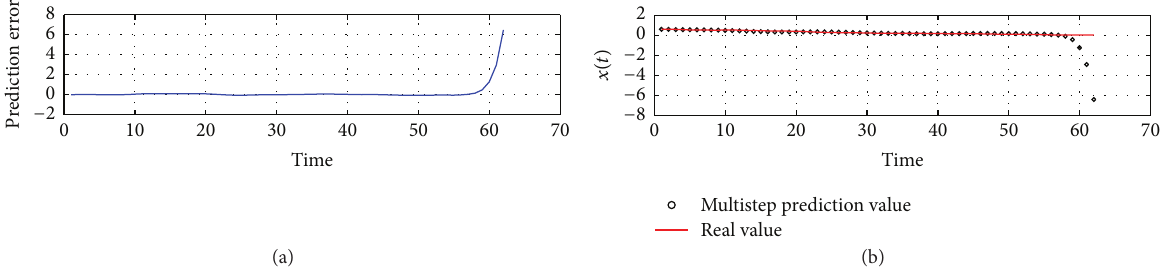
Figure 12: Results of Sunspot time series: (a) multistep prediction error and (b) the original and multistep prediction values, respectively.